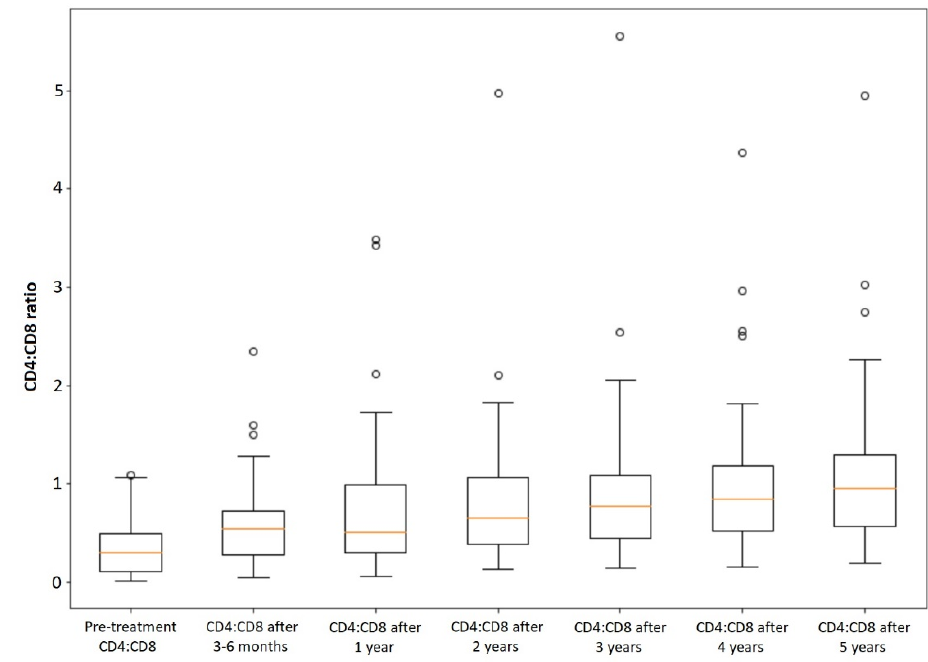
Figure 2. CD4:CD8 ratio growth among all patients. The hollow circle stands for the outlier. Table 3. CD4 cell count and CD4:CD8 ratio recovery depending on clinical